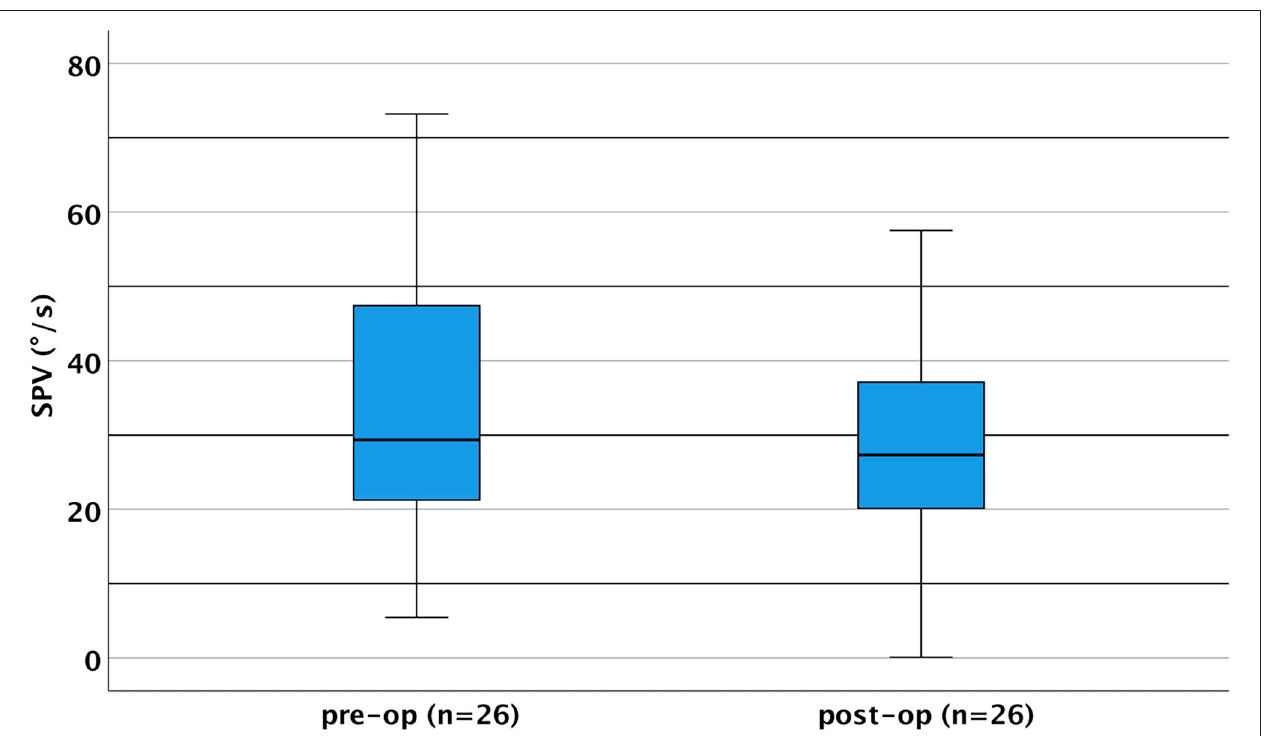
Frontiers in Neurology |